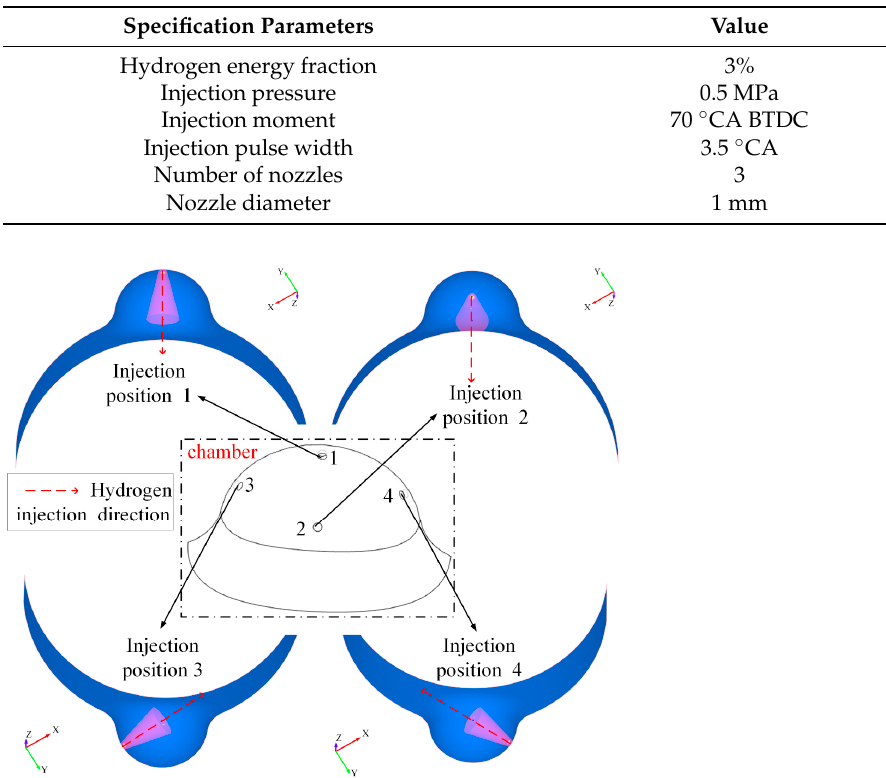
Table 3. Specific parameters of hydrogen DI in engine.